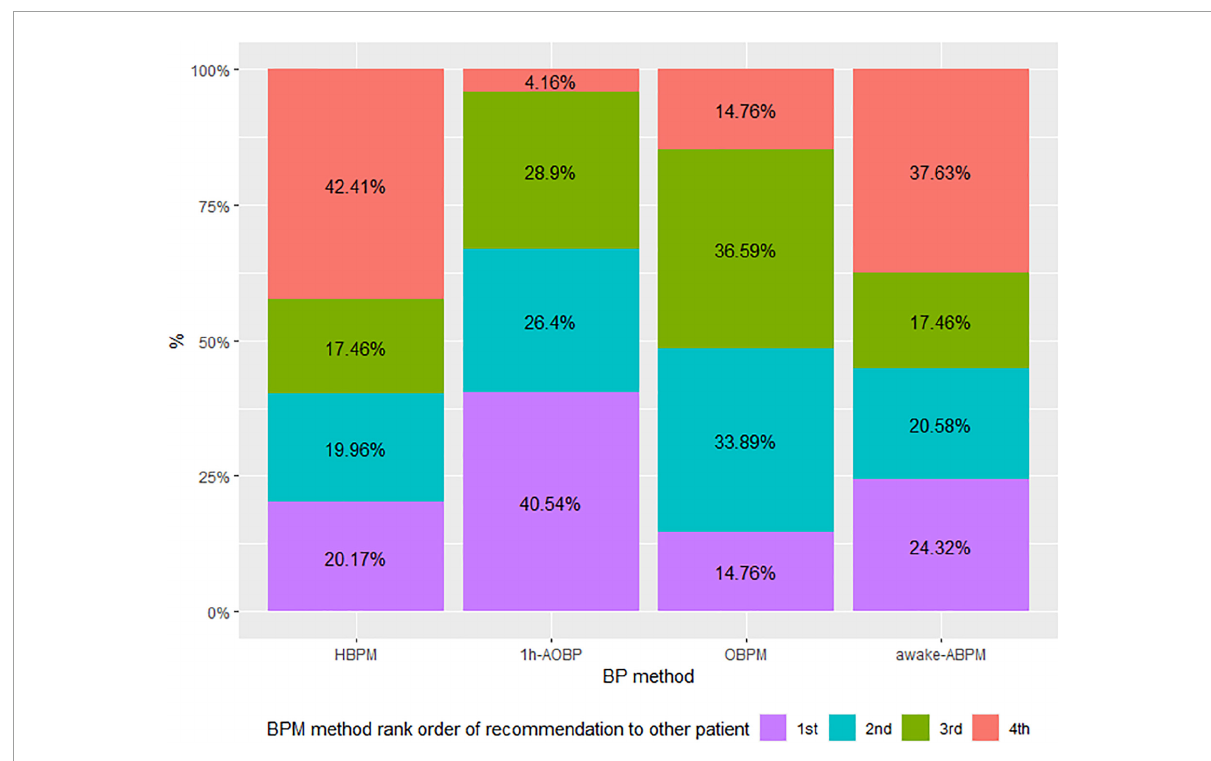
FIGURE2 Lower part: staked bar chart with participants rank order of recommendation of each BP method to other patients. HBPM, Home blood pressure monitoring. 1 h-AOBP, 1 h- automated office blood pressure measurement; OBPM, Office Blood Pressure measurement; Awake-ABPM, Awake ambulatory blood pressure monitoring.